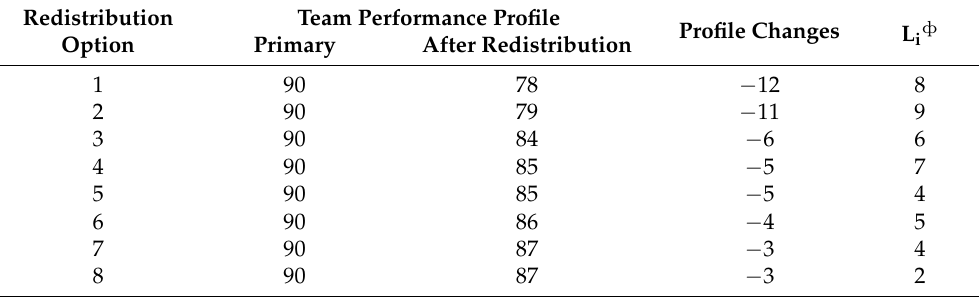
Table 8. Changing the profile of project team characteristics as a result of redeployment.